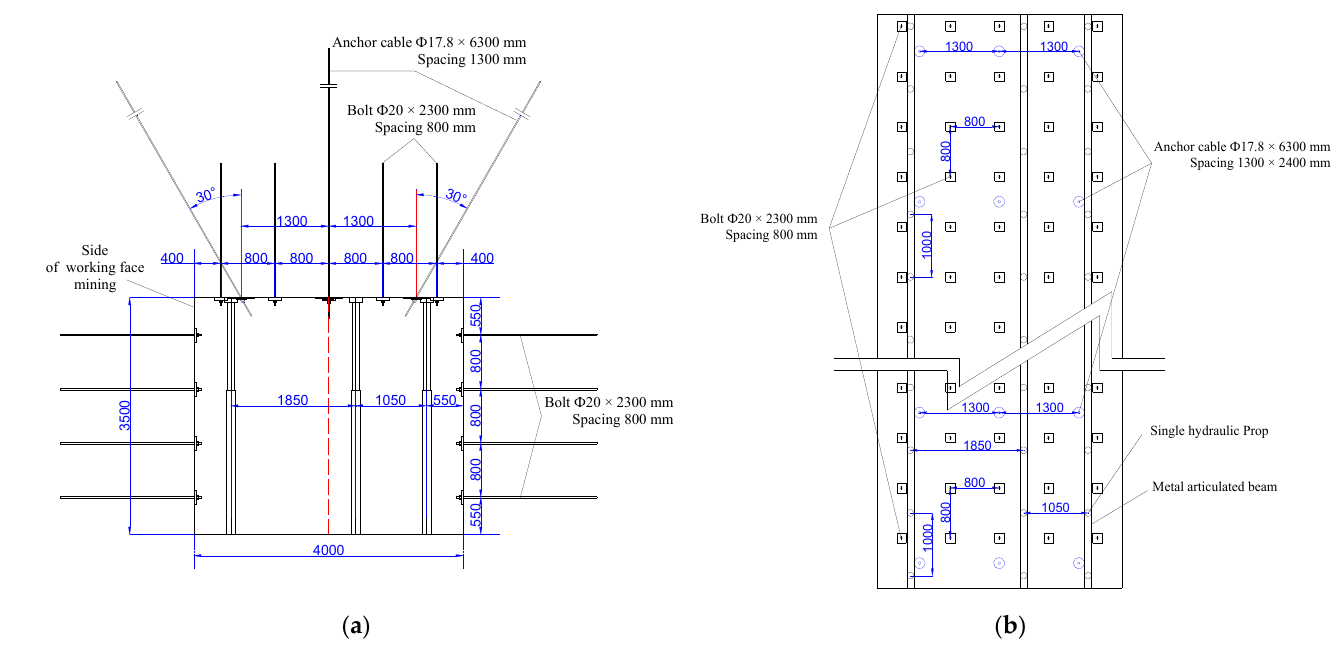
Figure 2. The 1304 working face return air roadway single hydraulic prop advance support diagram. ( a ) The 1304 working face return airway roadway support section diagram; ( b ) The 1304 working face return airway roof support top